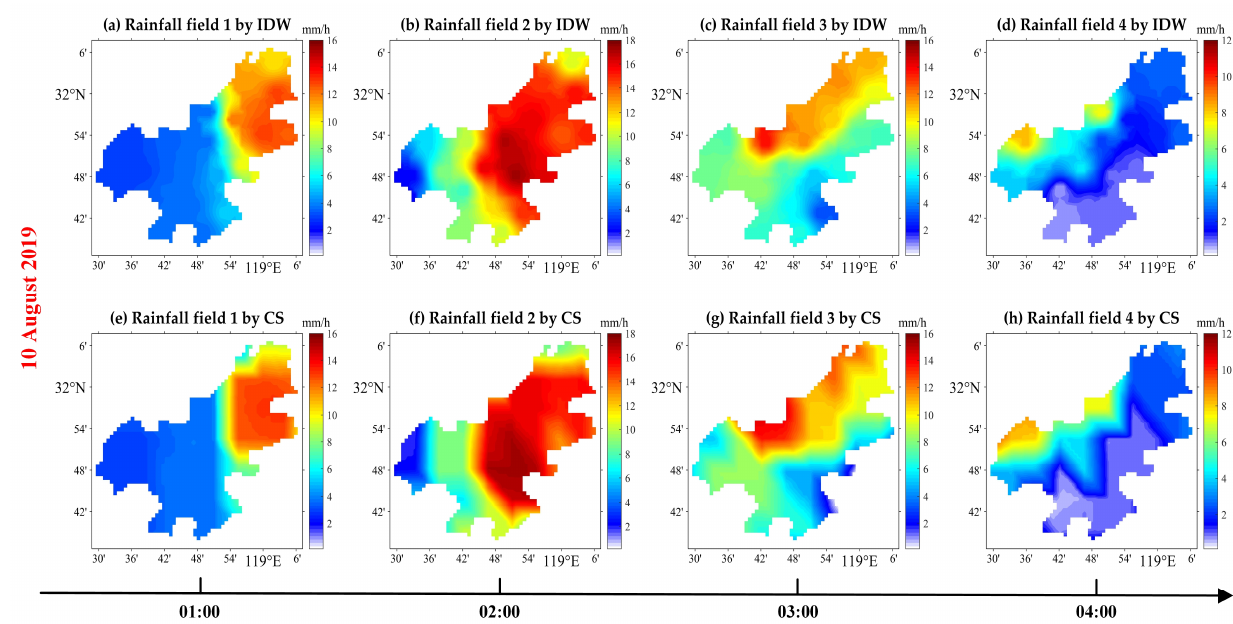
Figure 5. Results of reconstructing the rainfall fields of the rainfall event with ESL network 1 for the case of no noise. ( a – d ) represent the rainfall fields reconstructed by the IDW algorithm, and ( e – h ) represent the rainfall fields reconstructed by CS.